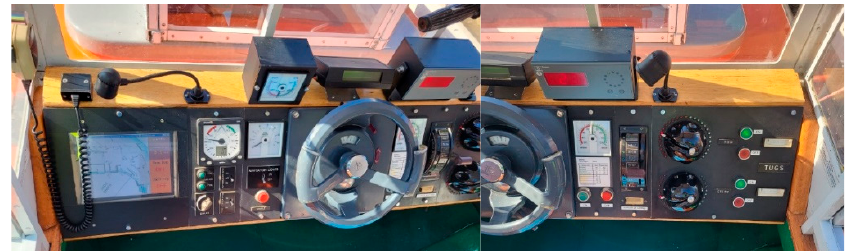
Figure 2. Control panel with indicators of speed, course, rate of turn, rudder angle, and engine telegraph on the model bridge.